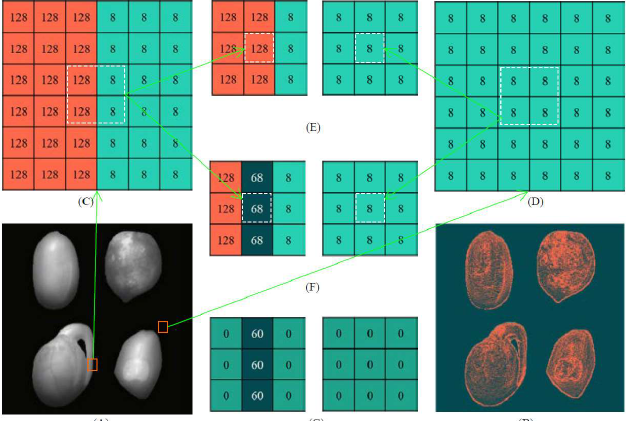
Figure 6. Example of image texture feature extraction based on pooling operation: ( A ) Peanut gray- scale image; ( B ) Texture map; ( C ) Peanut contour area grayscale matrix; ( D ) Background grayscale matrix; ( E ) Result of MaxPool; ( F ) Result of AvePool; ( G ) Result of MaxPool minus AvePool; The arrows in the figure indicate the direction of data flow.